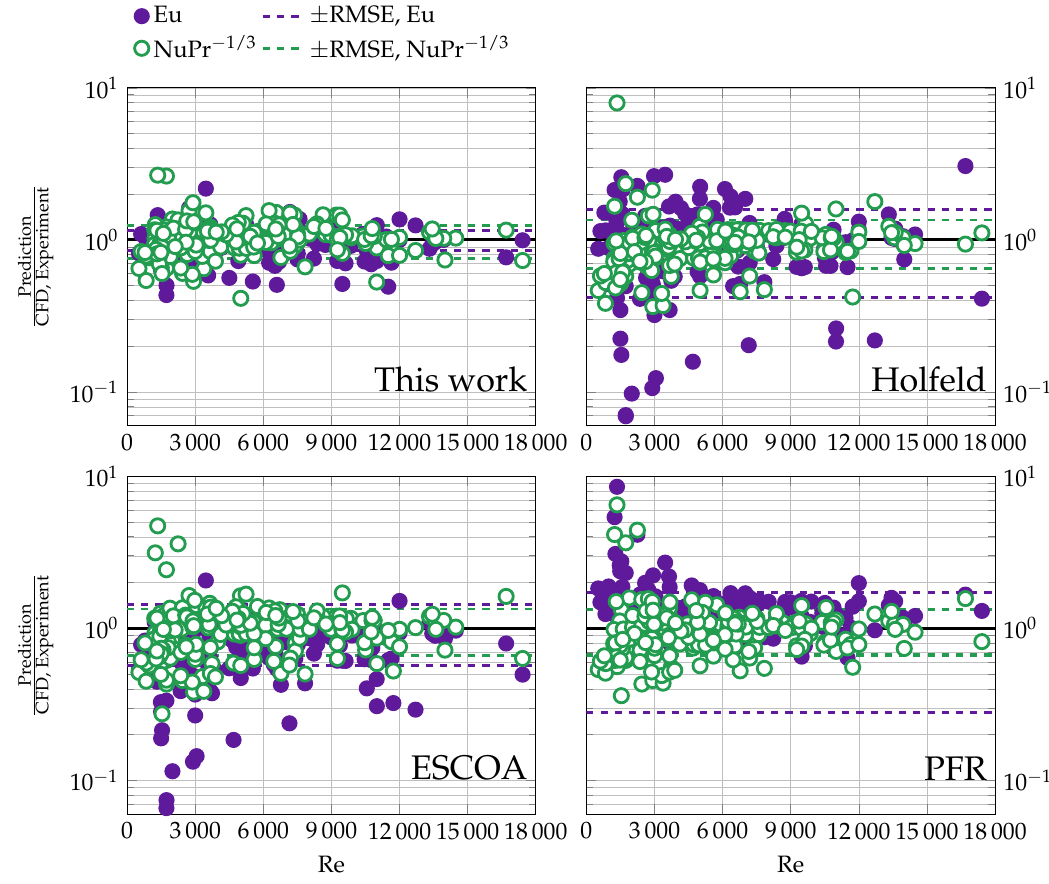
Figure 3. Predictive accuracy on regression and validation data (208 data points): correlations developed in this work (Supplementary Materials) and correlations from Holfeld [17], Escoa [18] and PFR